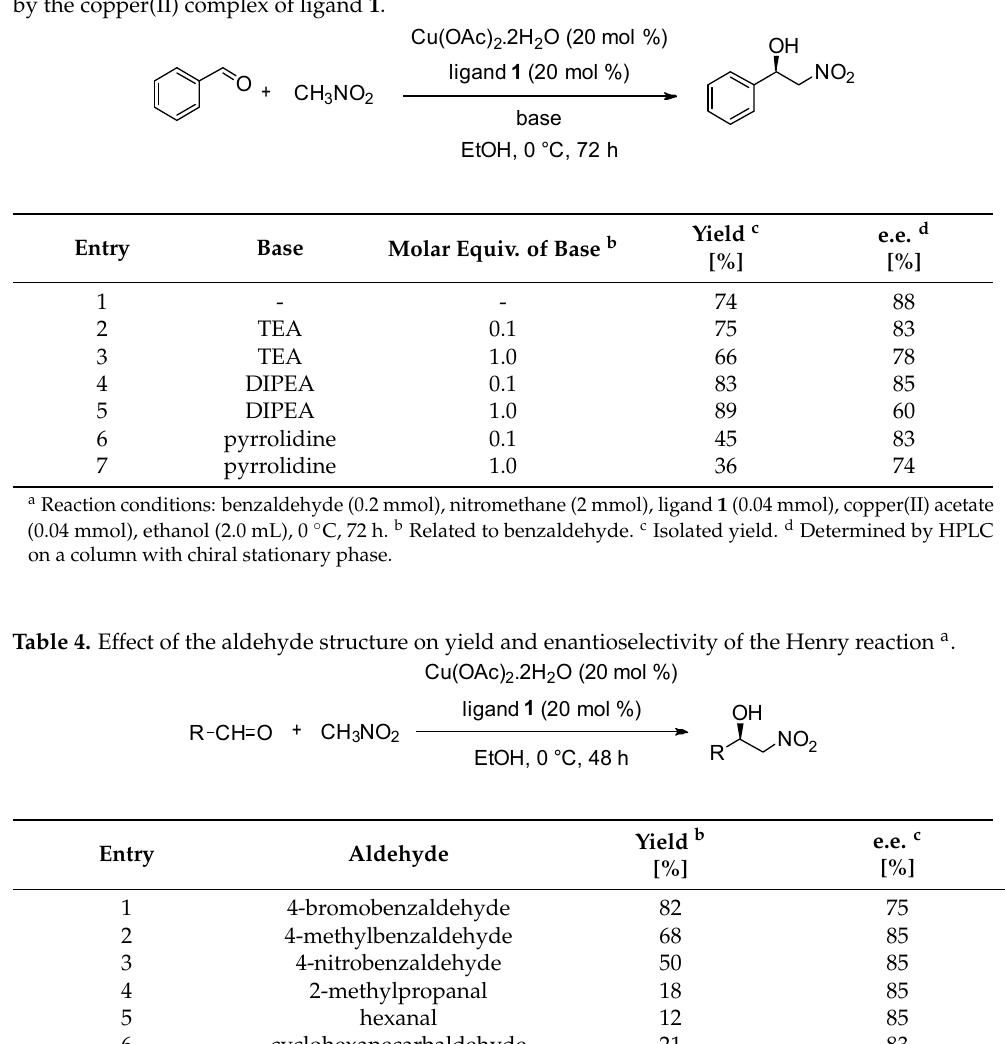
3-phenylpropanal per(II) acetate (0.04 mmol), ethanol (2.0 mL), 0 °C, 48 h. b Isolated yield. c Determined by HPLC on a